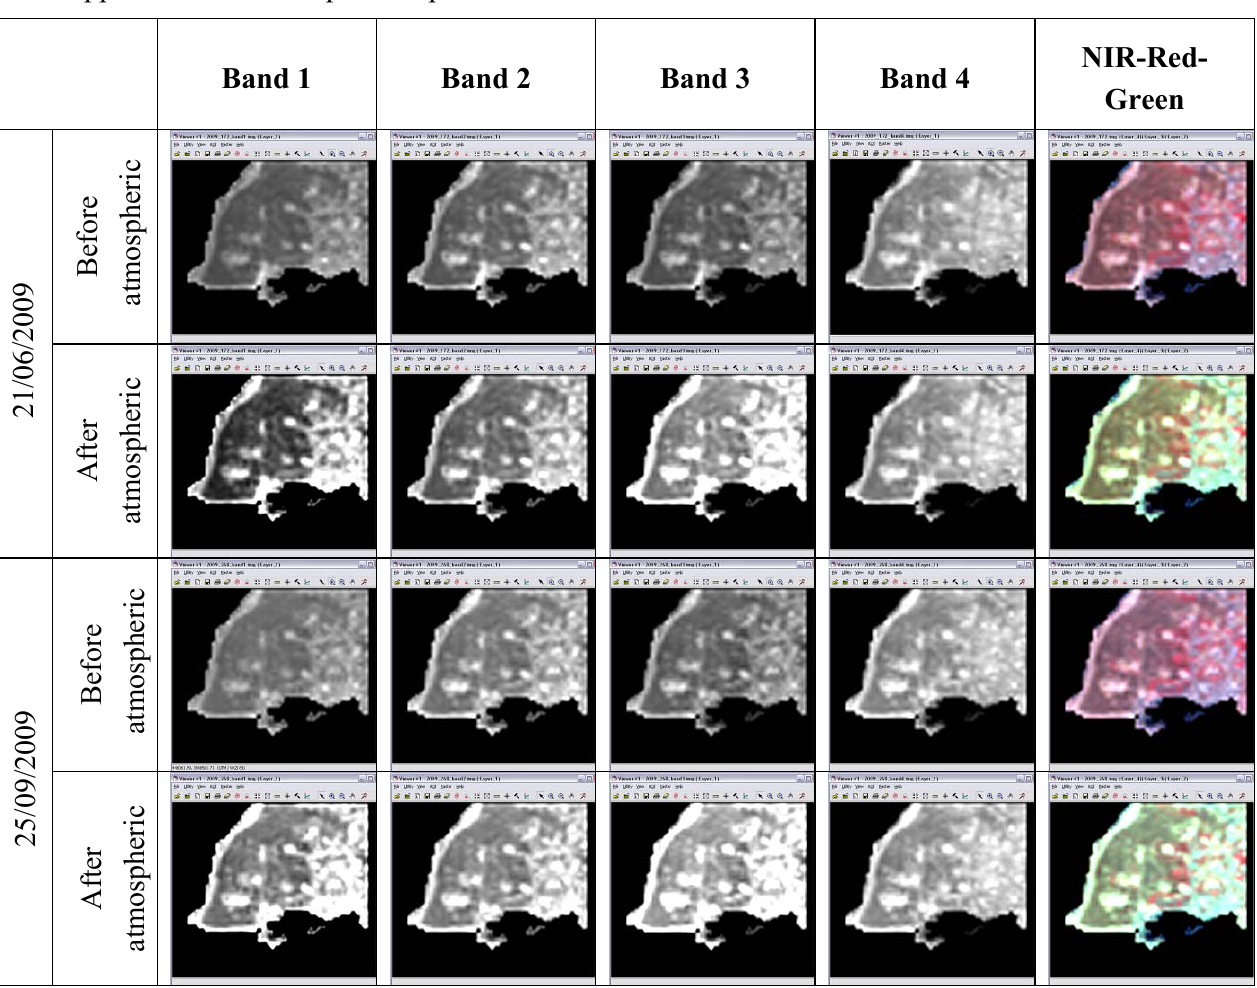
Table 8. Interpretation of the results before and after the DP atmospheric correction applied at the Nea Paphos crop